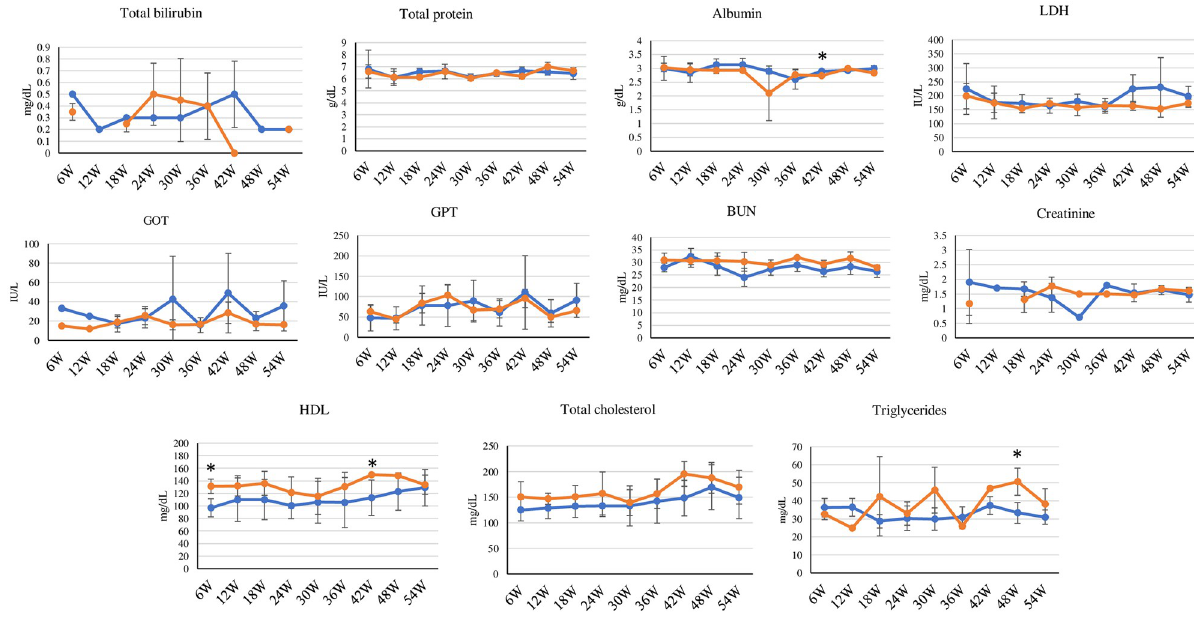
Fig 4. Time courses of serum biochemical changes (mean ± SD) in time courses of the control (blue) and BDE-209 treatment (orange) groups ( � : Significant differences between two groups, P < 0.05).